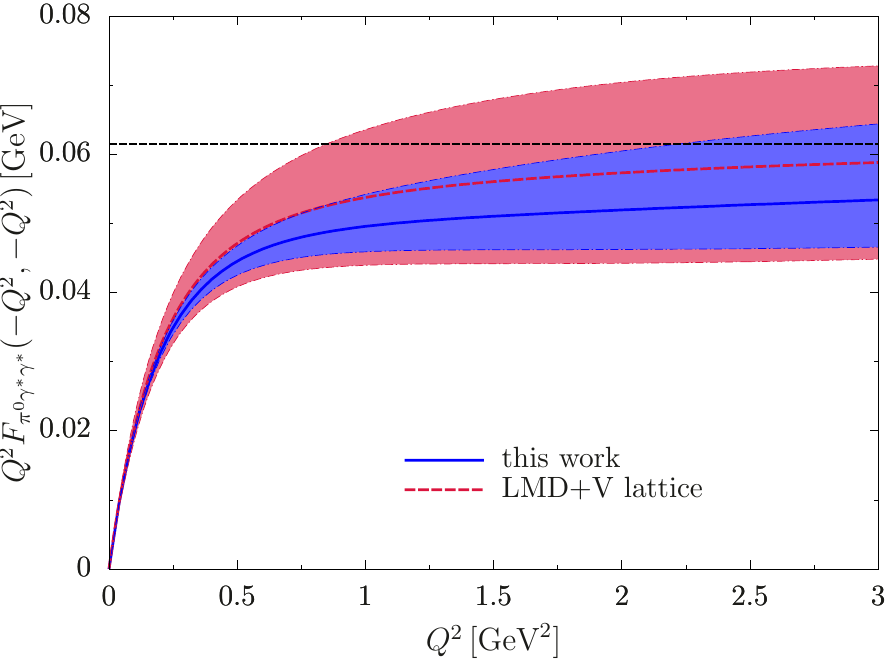
2 ; Q 2 ) versus Q 2 at low energies (blue solid (cid:25) 0 (cid:13) (cid:3) (cid:13) (cid:3) ( (cid:0) Q (cid:0)